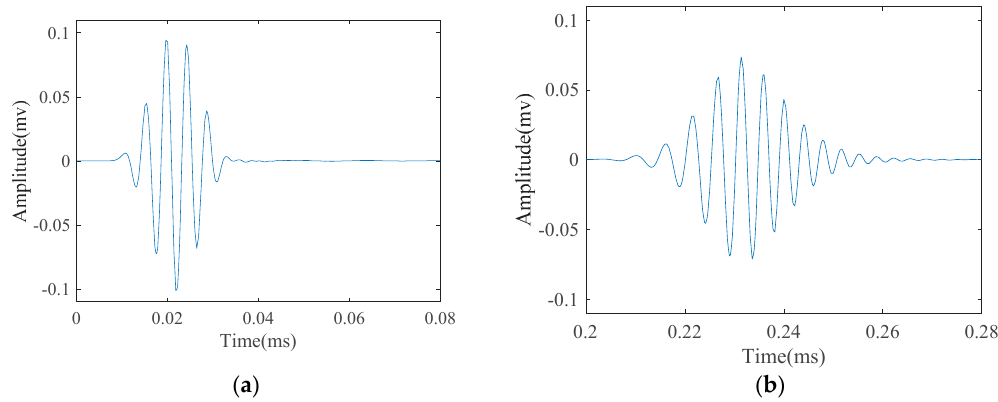
Figure 2. L(0,2) mode as emitted a five-cycle tone-burst signal in a normal pipe after propagating a distance of: ( a ) 50 mm; and ( b ) 1050 mm along the pipe axial length.